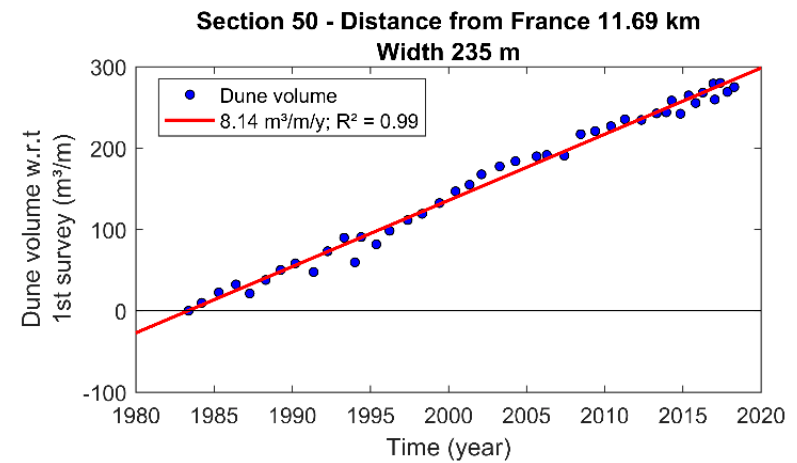
Figure 9. Example of dune volume in time combined with a linear fit (correlation of determination R² = 0.99) for coastal section 50 (natural dunes).